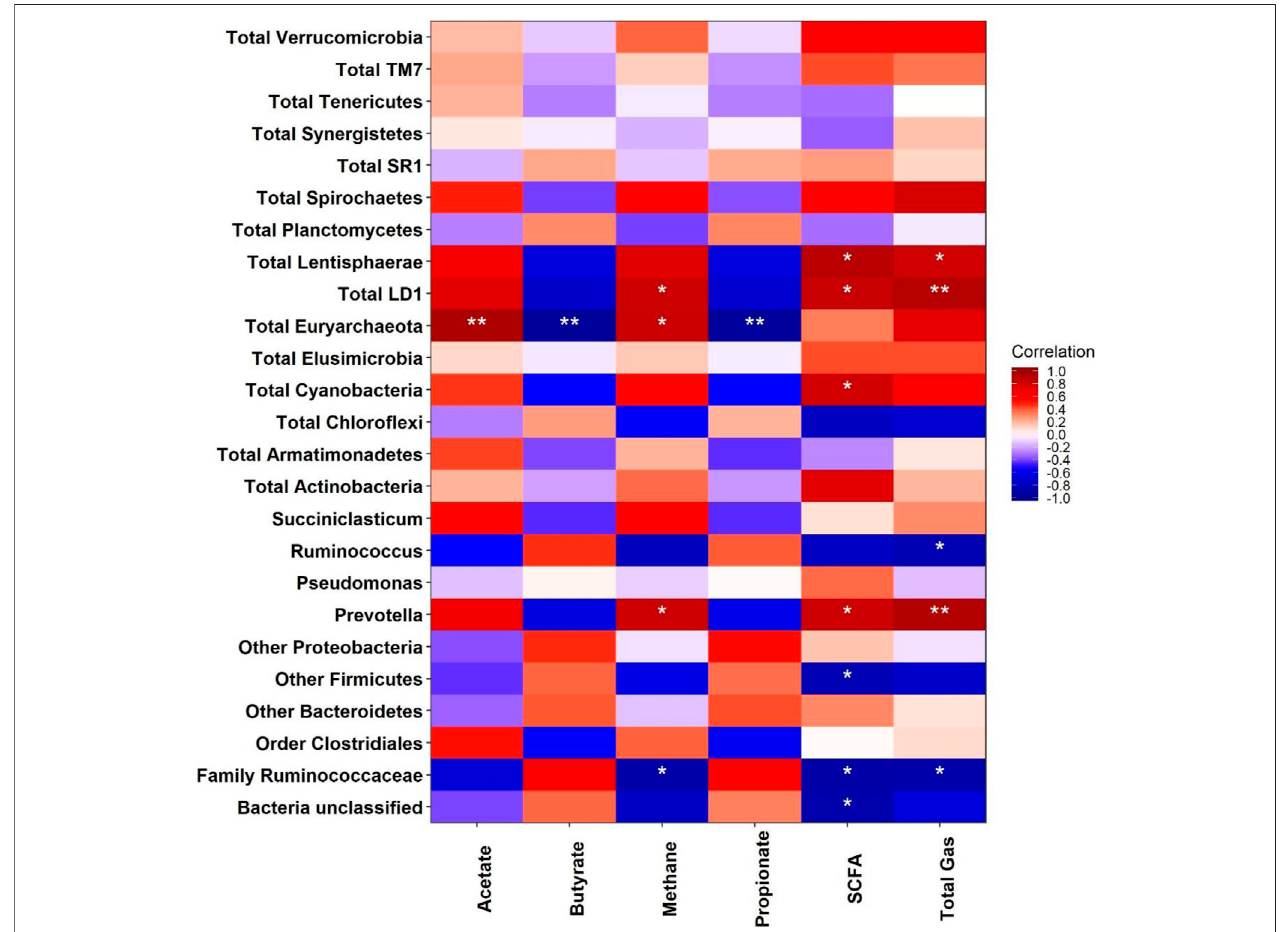
FIGURE 4 | Correlation between rumen fermentation parameters and the microbiota identi fi ed from phylum to genus.